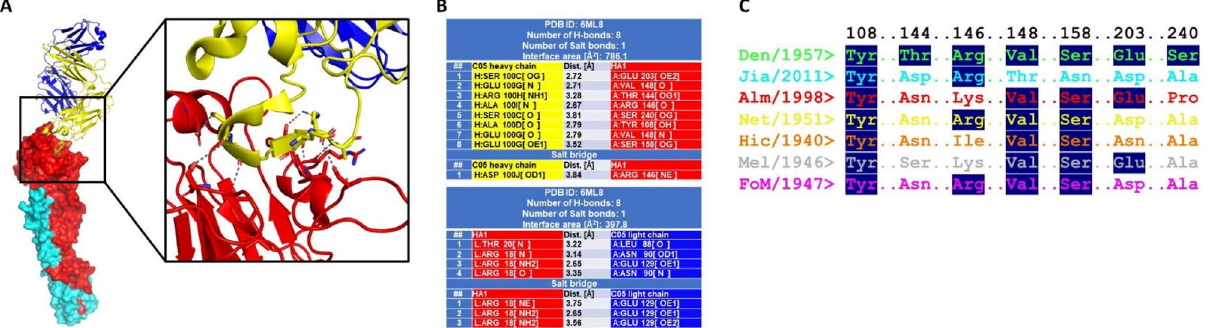
Figure 4. Analysis of the structure of HA from H1N1 influenza strain A/Denver/57 complexed with the antibody C05 Fab (PDB ID: 6ML8). ( A ) Structure of the HA: C05 complex. HA1 segment is in red; HA2 segment is in cyan; C05 heavy chain is in yellow; C05 light chain is in blue. Zoomed view to show the interaction between HA1 and the C05 heavy chain. Grey dashed lines indicate hydrogen bonds. ( B ) List of interactions between HA1 (red) and the C05 heavy chain (yellow) and light chain (blue). ( C ) Sequence alignment of the interacting residues in all seven HAs, compared to the HA: C05 complex (PDB ID: